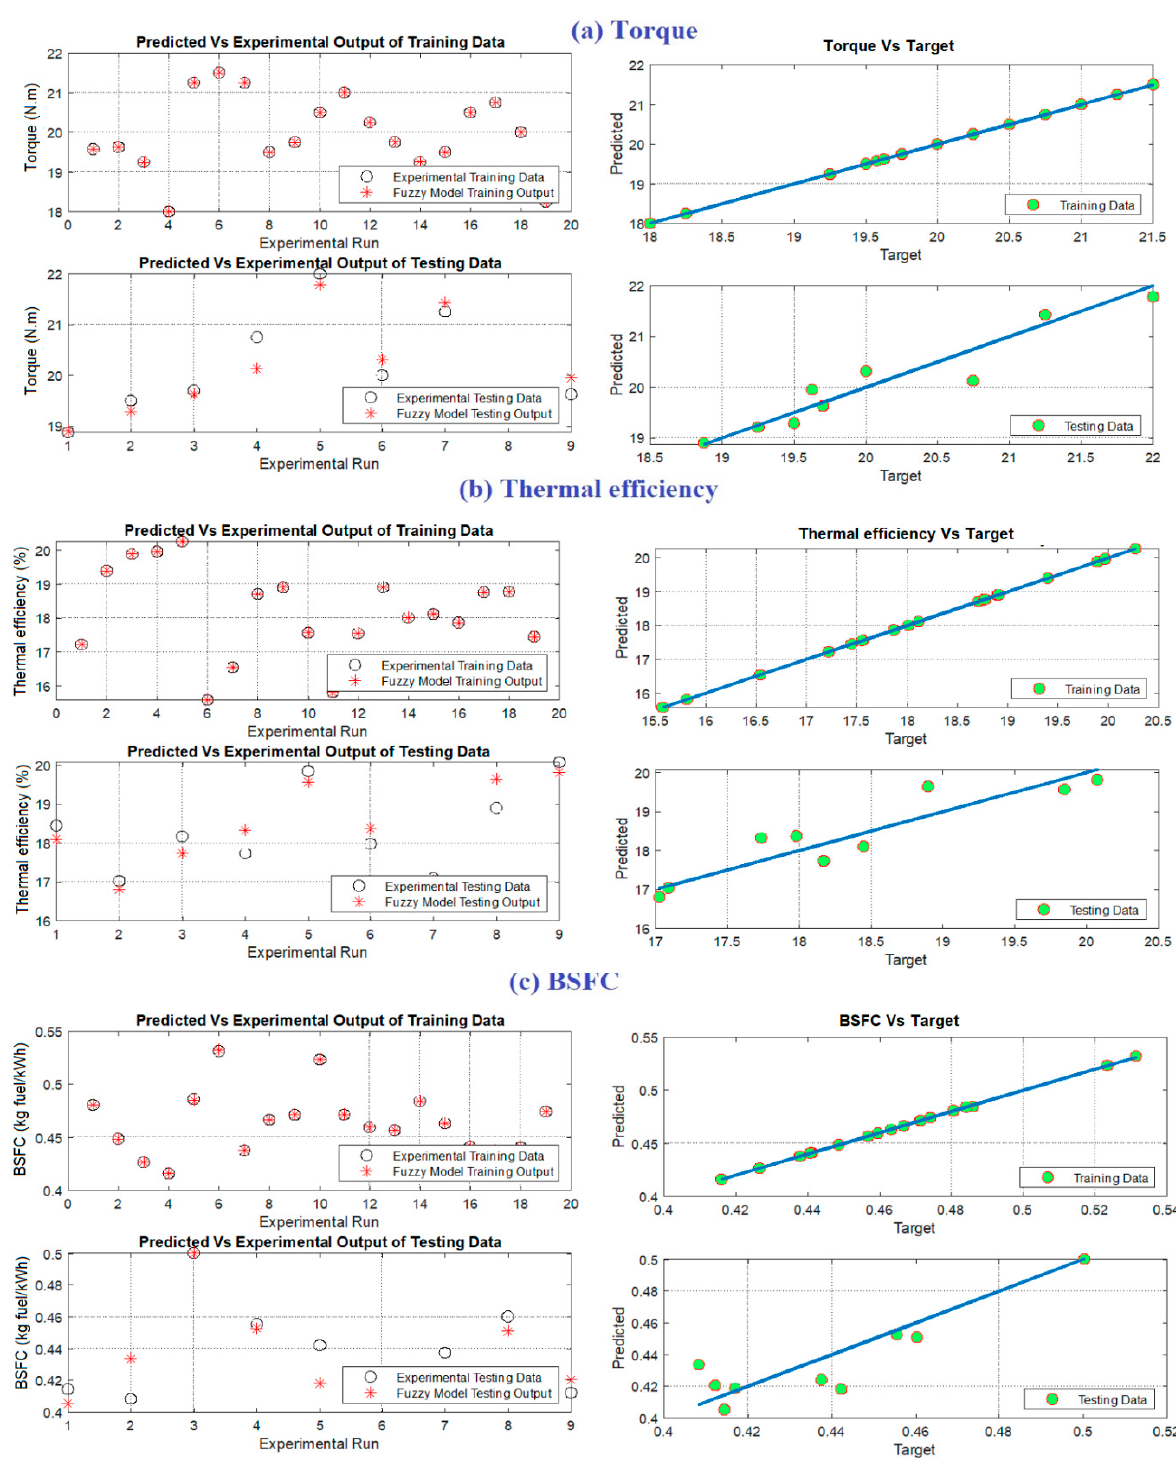
Figure 8. Fuzzy models’ prediction precision.